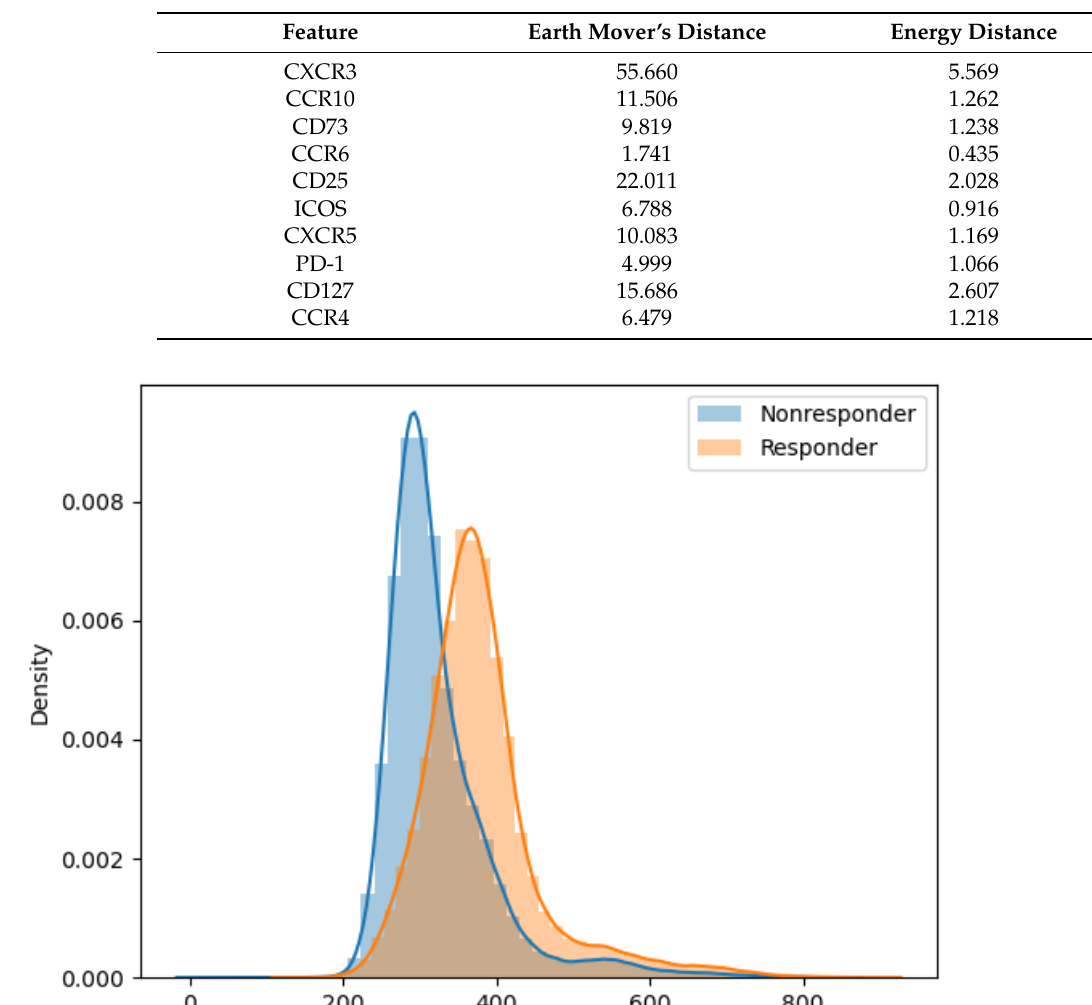
Table 5. EMD and ED measures (computed from the ECDFs shown in Figure 9) between responders and nonresponders for CXCR3 and other nine markers. (Adaptive panel, Naïve CD4+ T cells, day 1). Feature Earth Mover’s Distance